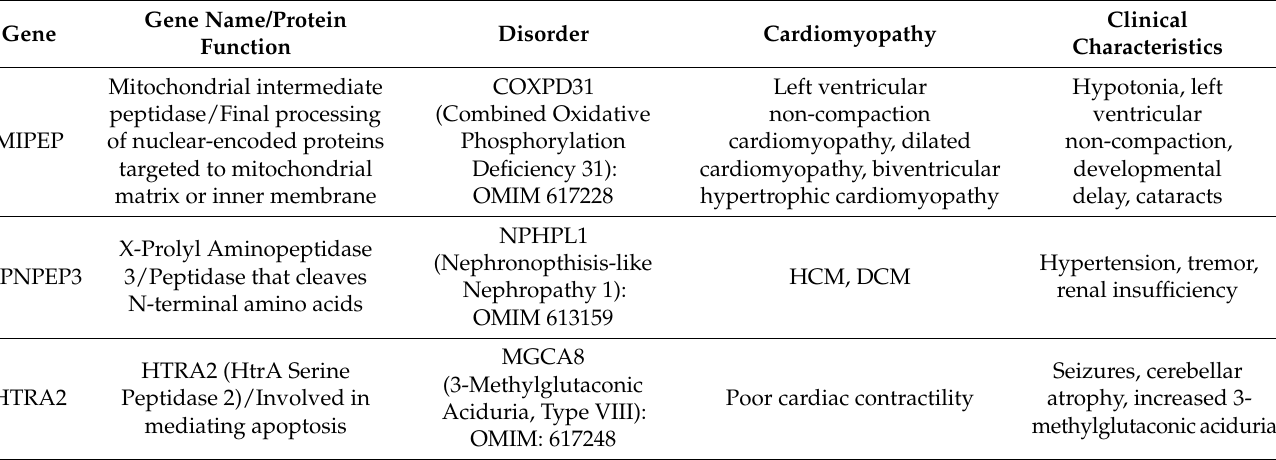
Table 2. Disorders presenting with cardiomyopathy that are involved in mitochondrial preprotein processing inside the mitochondrial matrix. Formal Online Mendelian Inheritance in Man (OMIM) report, protein function, and clinical characteristics are